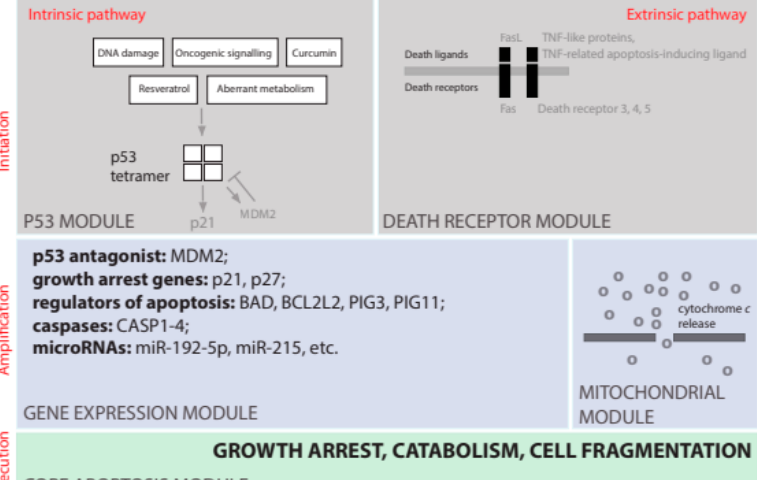
Figure 3. A circuit board for initiation, amplification, and execution of apoptosis. Apoptosis is initiated through either a p53-dependent (intrinsic) or independent (extrinsic) pathway. The intrin- sic apoptosis pathway is p53-dependent [34] and is initiated by pathological internal cellular states